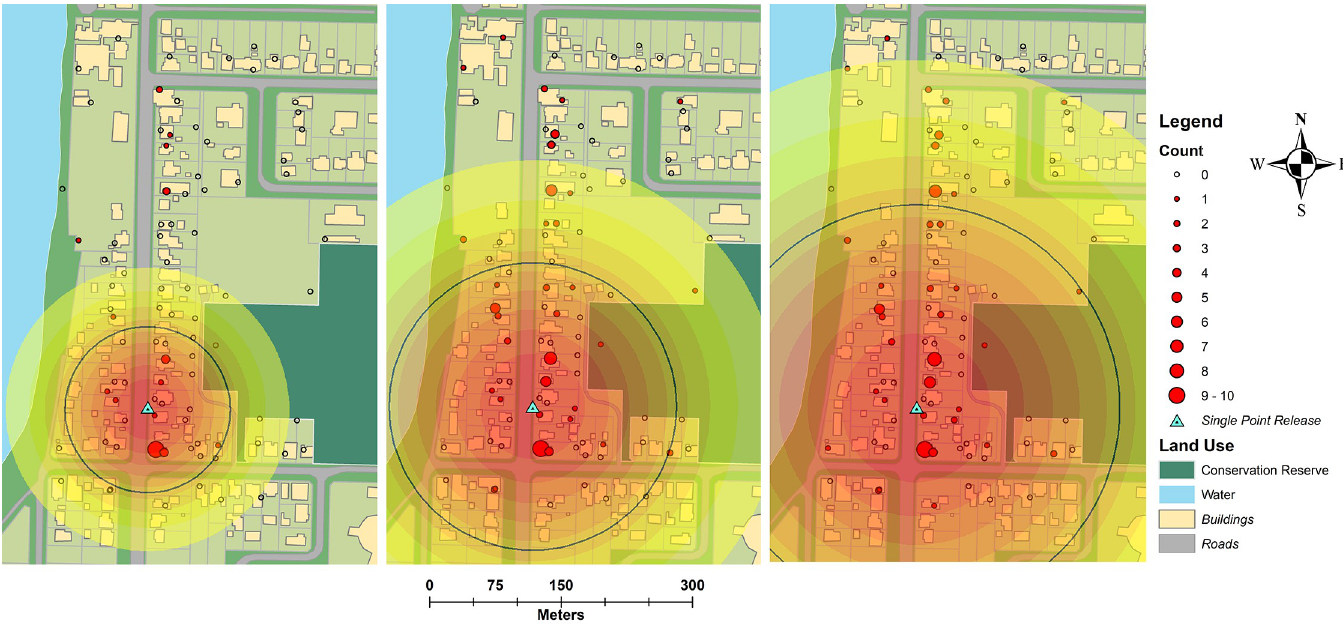
Fig 6. Single point estimates of Aedes aegypti movement during experiment six which apply the STEIK framework. Concentric circles from release point are density estimates of marked adult male Aedes aegypti one (A), three (B) and six (C) days post release. Black lines represent mean distance travelled over the time period. Landuse basemap digitized manually